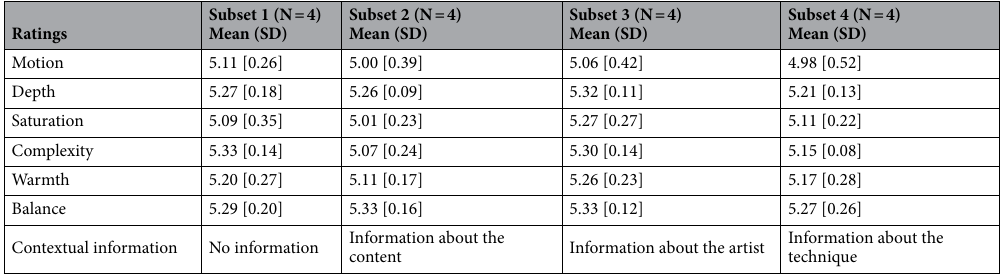
Table 3. Mean ratings of motion, liking, interest, and complexity across the three subsets of paintings. N = number of paintings, SD = standard